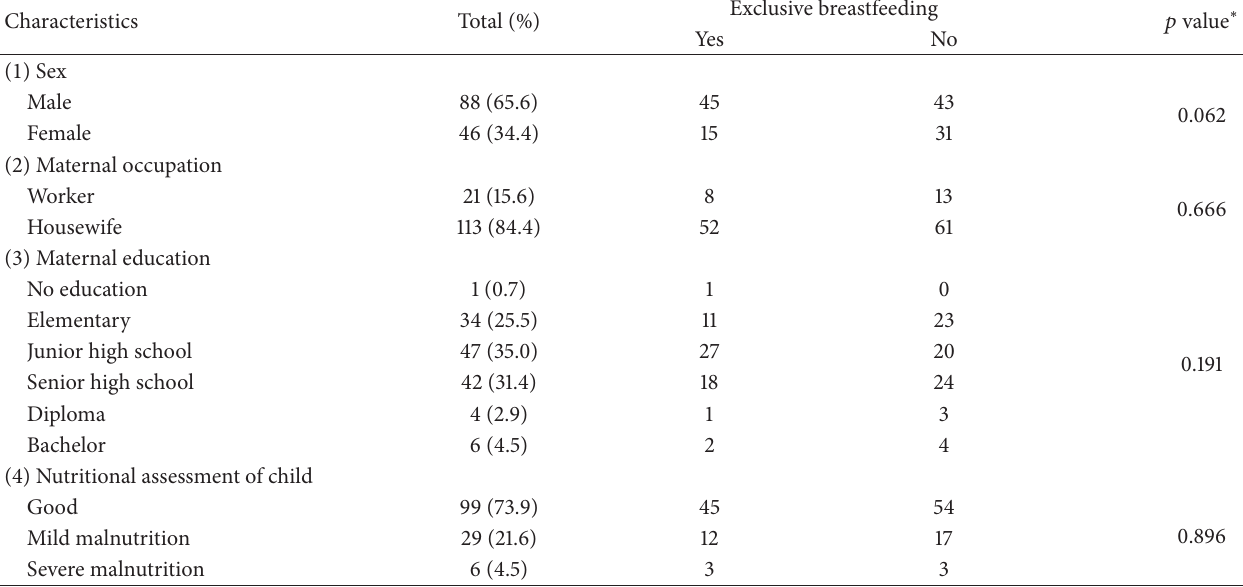
Table 1: Exclusive breastfeeding based on sociodemographic